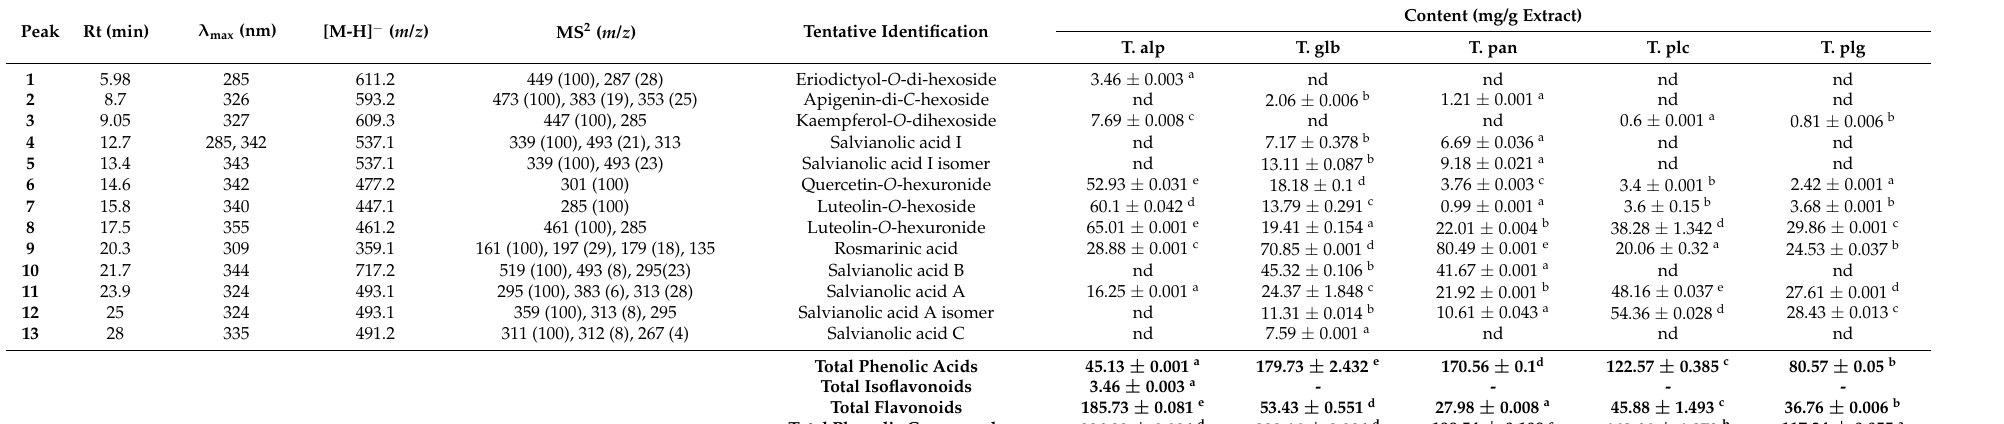
Table 2. Identification and quantification data of phenolic compounds analyzed from Thymus samples. Statistical differences were evaluated by implementing